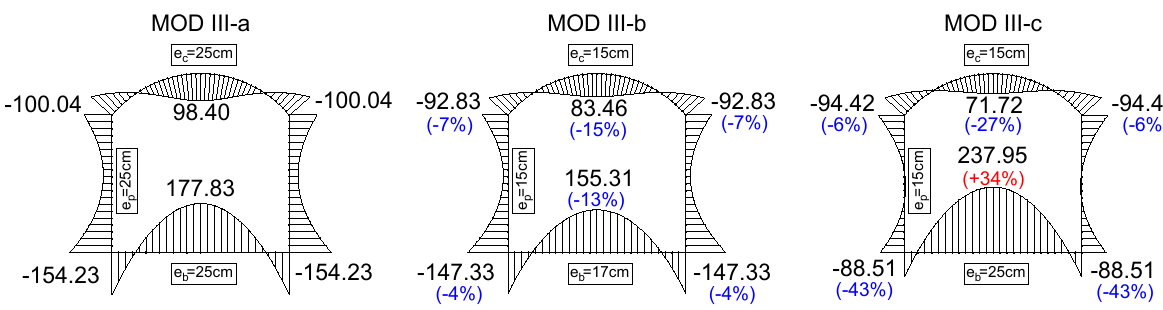
When the thickness of Series “a” was reduced to that of Series “b”, the value of the moments of all critical sections were reduced, reaching 15% in the critical MLC section. The thinnest wall provided the strongest interaction between the structure and the soil. However, when the 0.25 m thickness in the bottom slab was maintained and the thickness of the side walls and roof slab was reduced to 0.15 m (Series “c”), the rearrangement of the bending moments in MOD III- c displayed unique characteristics. The higher flexural stiffness (EI) caused the bottom slab to concentrate greater bending moment (34% increase in the MLF section compared to the MOD III-a culvert), but the bending moment in the middle of the roof slab (MLC) and in the lower corners (CIQ) significantly decreased, showing 27% and 43% reductions, respectively.